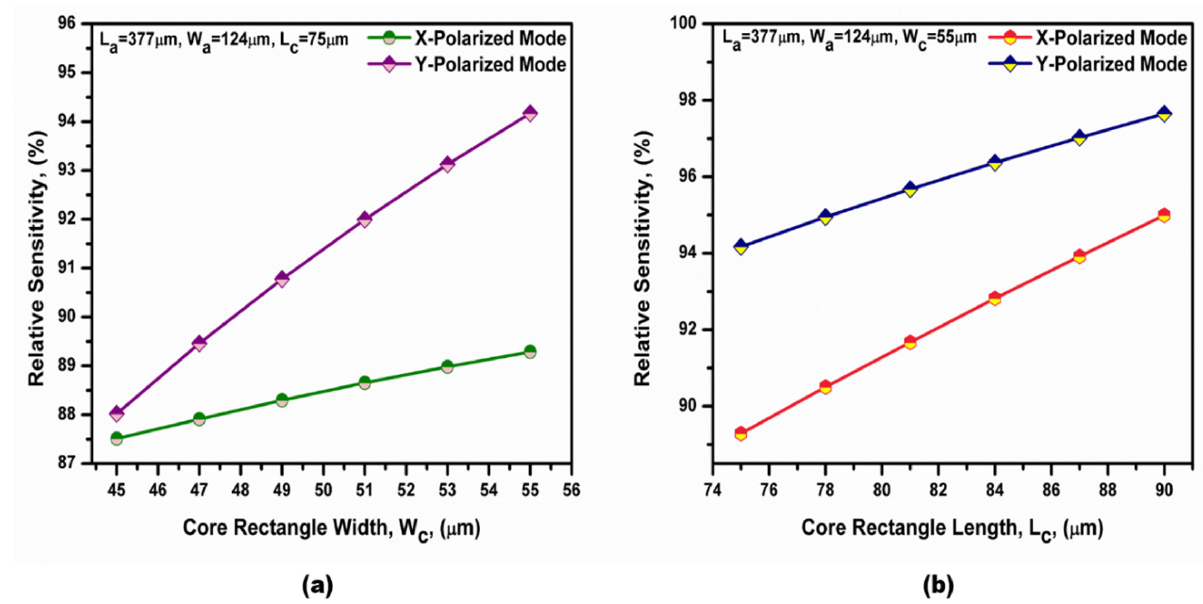
Figure 11. Dependence of the relative sensitivity on ( a ) the cladding rectangular hole width ( W c ) and ( b ) the cladding rectangular hole length ( L c ) at a bilirubin concentration equal to 4 µmol/L and f = 0.75 THz.